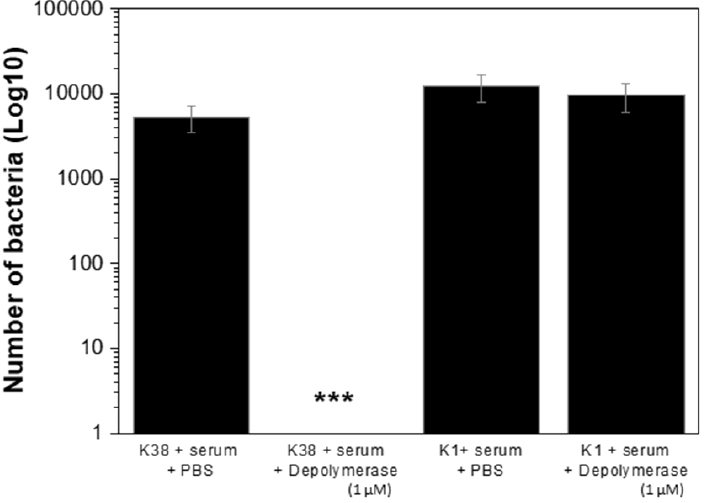
Figure 4. Serum assay. The survival of phage host K38 and non-host K1 strains against the serum complement collected from healthy human subjects, was assessed in the presence of PBS (control) or K38 depolymerase at 1 µM (test). Significance was determined by Student’s t test (***, p < 0.001).